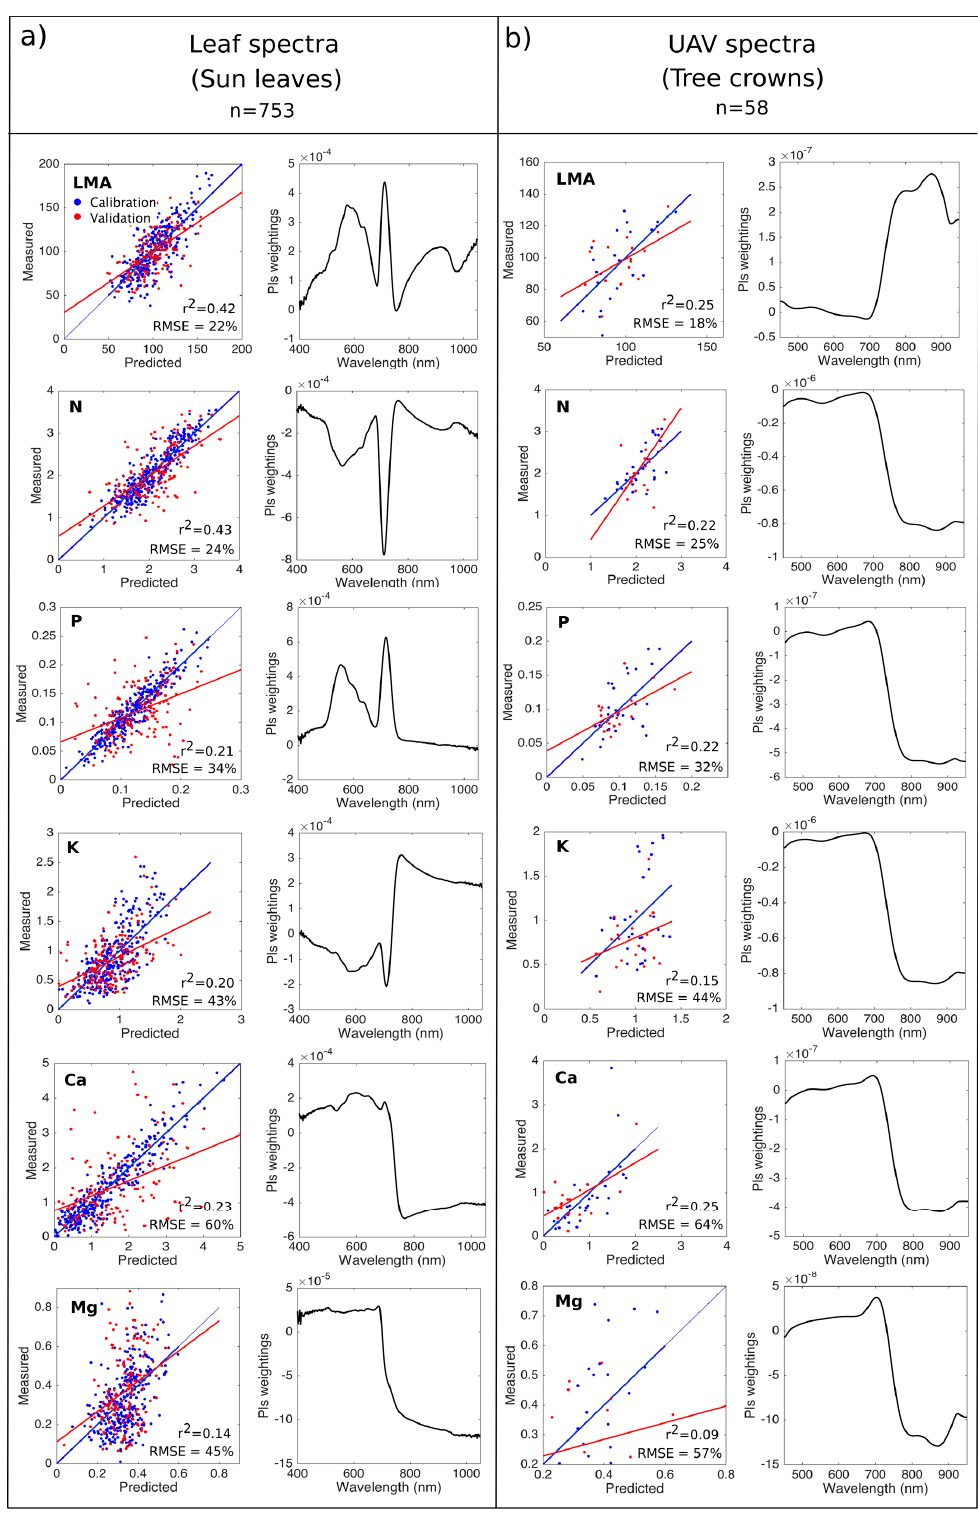
Figure 4. ( a , left ) Relationships between measured and predicted leaf traits using individual sun leaf reflectance spectra and PLS regression analysis. n = 753. Blue line = r 2 -cal regression line. Red line = r 2 -val regression line. RMSE and r 2 -val values displayed on graph. ( a , right ) PLSR spectral weightings for each leaf trait. Deviation from 0 indicates the parts of the spectrum that most strongly influence the empirical model. ( b ) The same as ( a ), but using UAV-collected reflectance spectra of 58 tree